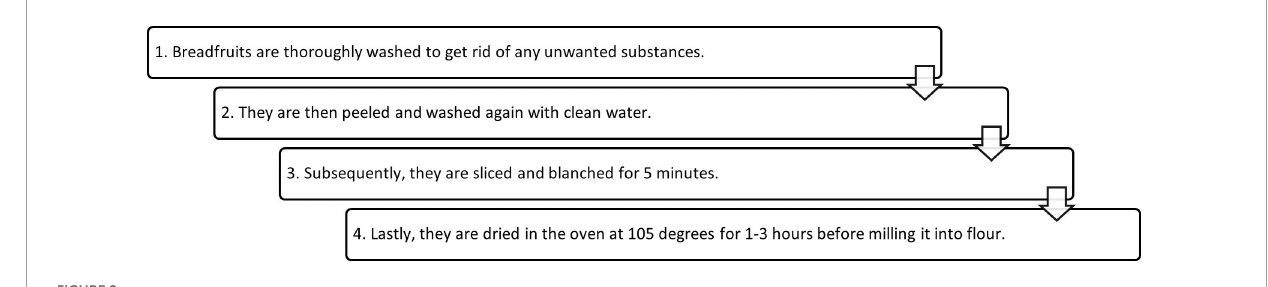
FIGURE2 Process of manufacturing breadfruit